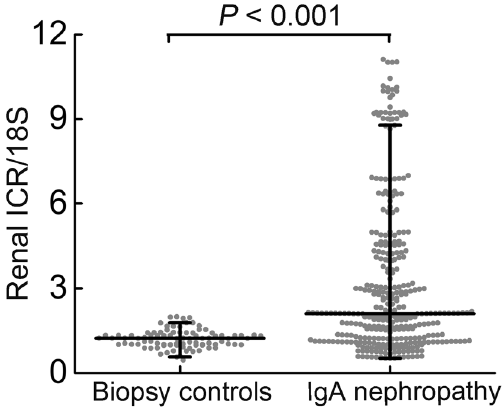
Figure 1. Renal ICR levels were significantly higher in patients with IgA nephropathy compared with biopsy controls. Renal ICR levels were detected by qPCR and normalized to 18S. IgA nephropathy, n = 337; Biopsy controls, n = 89. The horizontal lines from top down represent 75th percentile, median, and 25th percentile; the vertical lines represent interquartile range.